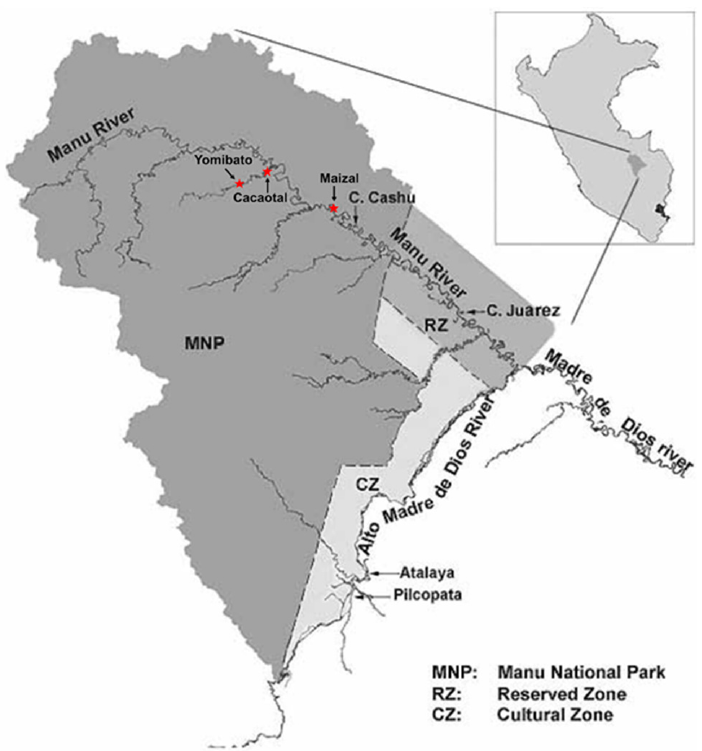
Figure 1. Map of Manu National Park, Peru. Location of Cacaotal, Yomibato, and Maizal are indicated by red stars on map.